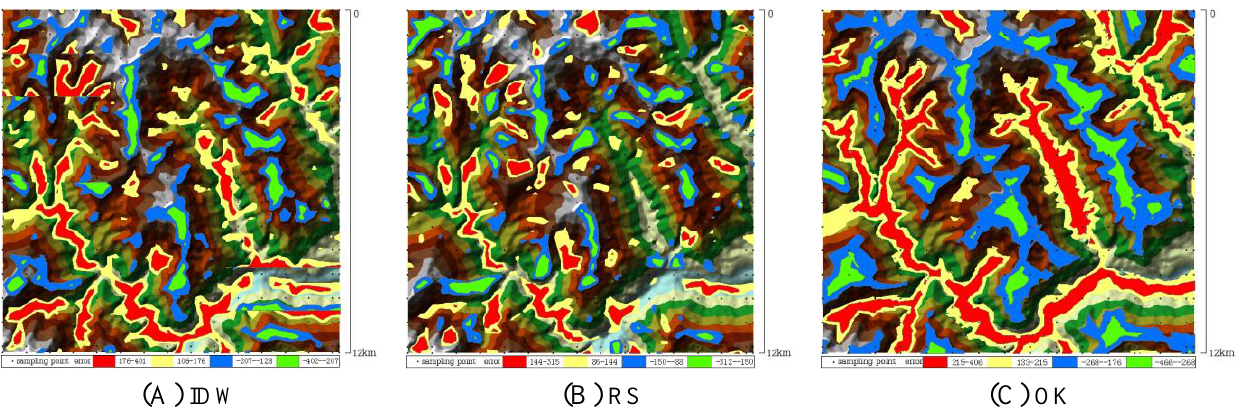
Figure 3. The distributions of errors in regular-grid sampling. ( A ) Error distributions of IDW; ( B ) Error distributions of IDW; ( C ) Error distributions of IDW.